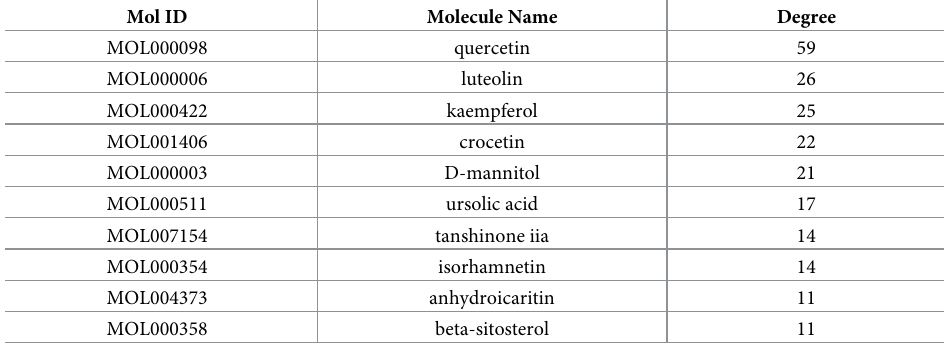
Table 1. Top 10 bioactive ingredients with a high